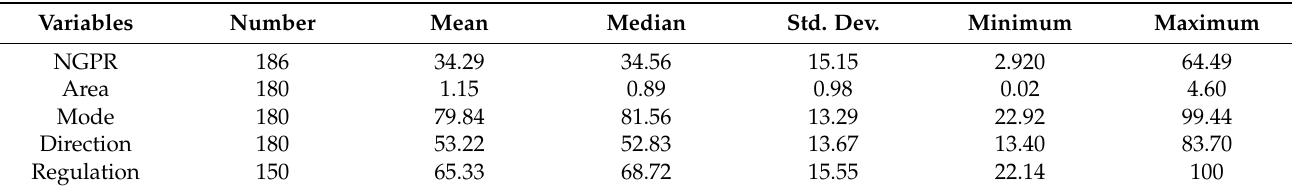
Table 2. Basic statistical description of